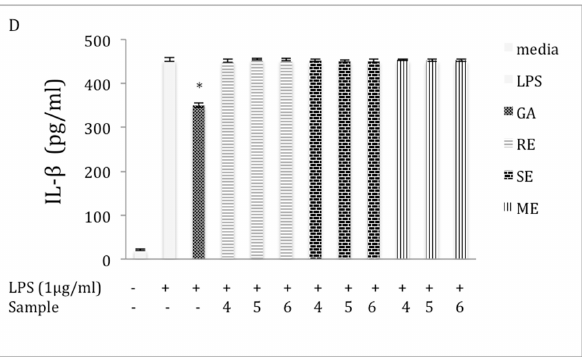
Figure 3. Effect of extracts and phenolics on tumor necrosis factor- α (TNF- α ) expression in macrophage RAW 264.7 cells ( A ) ASE extracts; ( B ) pure phenolic standards; ( C ) crude polysaccharide ex- tracts; and ( D ) different extraction methods. Cells were cultured in the absence or presence of LPS (1 μ g/mL) with various concentrations of different samples for 24 h (0 = media; GA = 2 μ M; 1= 5 μ M; 2 = 10 μ M; 3= 20 μ M; 4 = 50 μ g/mL; 5 = 100 μ g/mL; and 6= 150 μ g/mL; 7= 25 μ M; 8 = 50 μ M; and 9 = 100 μ M). TNF- α production was determined through an ELISA. The data represent the mean ± SE of triplicate experiments. Statistical significance p < 0.05 (*) was determined using one-way analysis of variance for independent means, followed by Tukey’s HSD test.